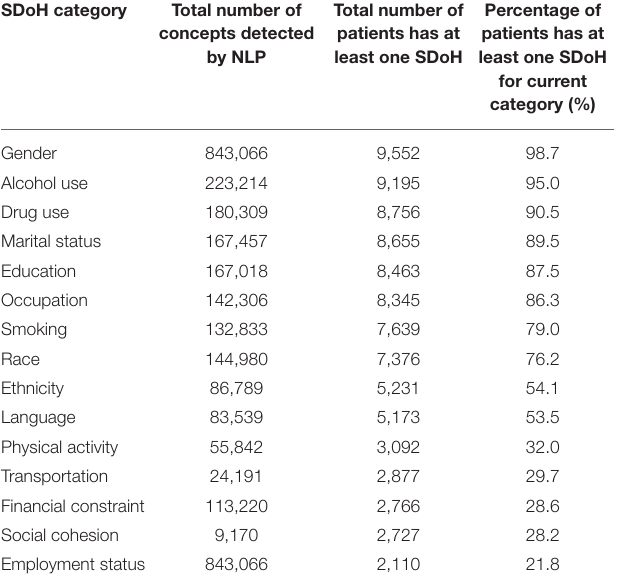
TABLE 2 | Social determinants of health (SDoH) concepts identified from the lung cancer patient cohort. SDoH